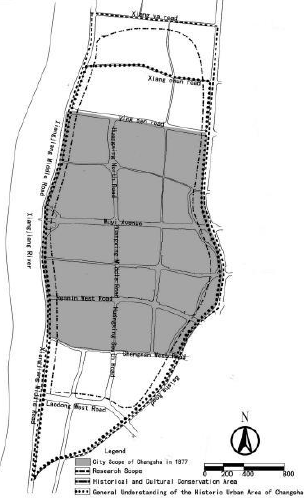
Figure 1. Research Scope.